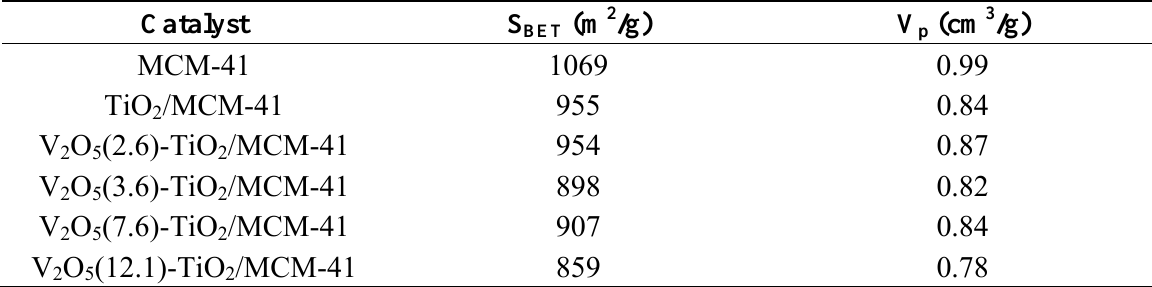
Table 2. BET surface area and pore volume of the catalysts.